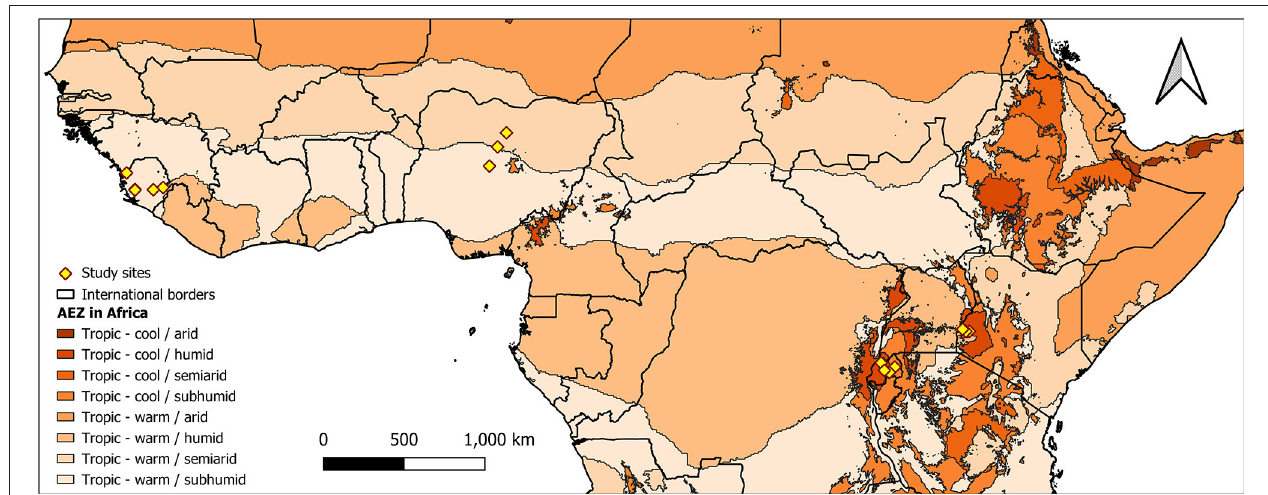
FIGURE 2 | Map showing location of farms (yellow diamond shape) where soils used in this study were collected from. Colored shading marks different agro-ecological